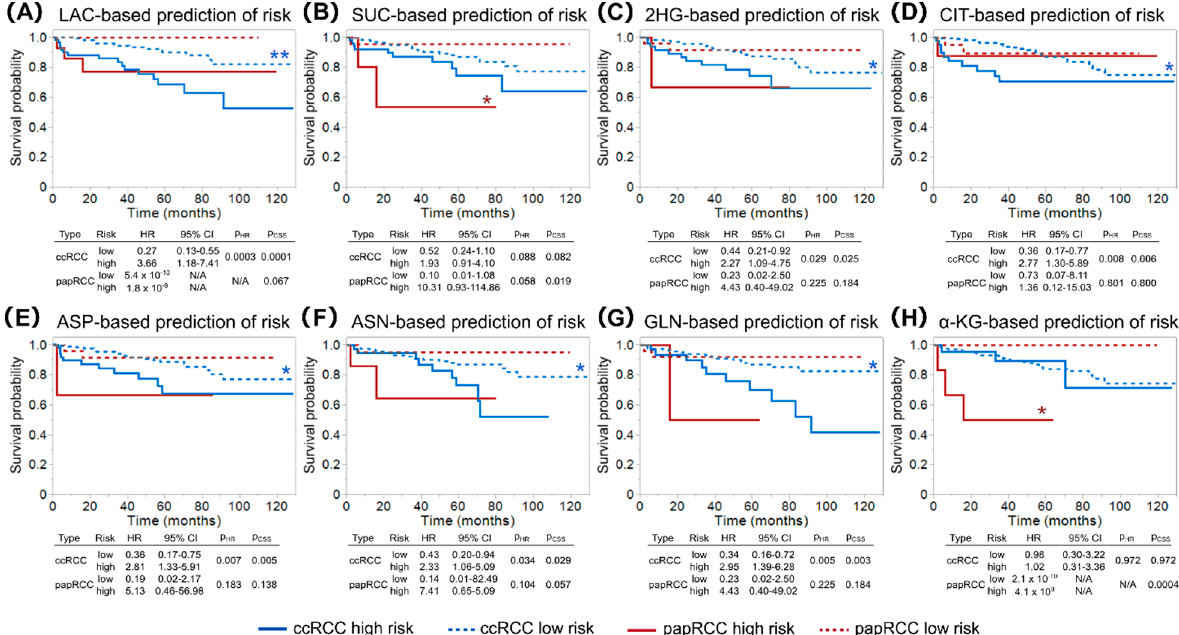
Figure 4. Survival analyses for risk predictions based on tumour metabolite levels of lactate ( A ), succinate ( B ), 2HG ( C ), citrate ( D ), aspartic acid ( E ), asparagine ( F ), glutamine ( G ), and α -KG ( H ). Metabolite-based predictions (low or high risk) were made by the bootstrap forest algorithm, and CSS was separately analysed for ccRCC ( n = 227) and papRCC ( n = 28) according to Kaplan–Meier (graphs) and Cox proportional hazard models (tables, HR—hazard ratios). Statistical difference was assessed by a log rank test for Kaplan–Meier analyses (pCSS) and a Wald test for Cox proportional hazards models (pHR). Significance was considered at * p < 0.05 and ** p < 0.001.